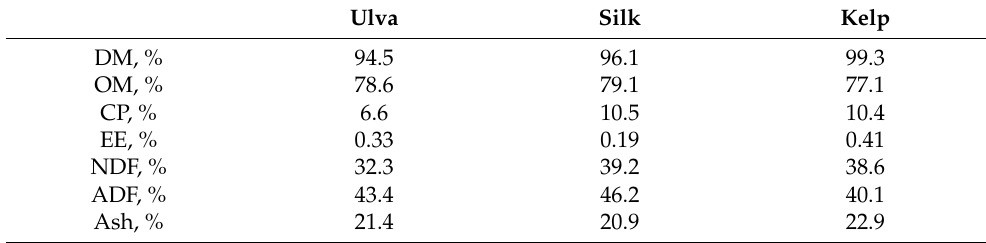
Table 2. Chemical composition (% DM basis) of the Ulva, Silk, and Kelp algae.